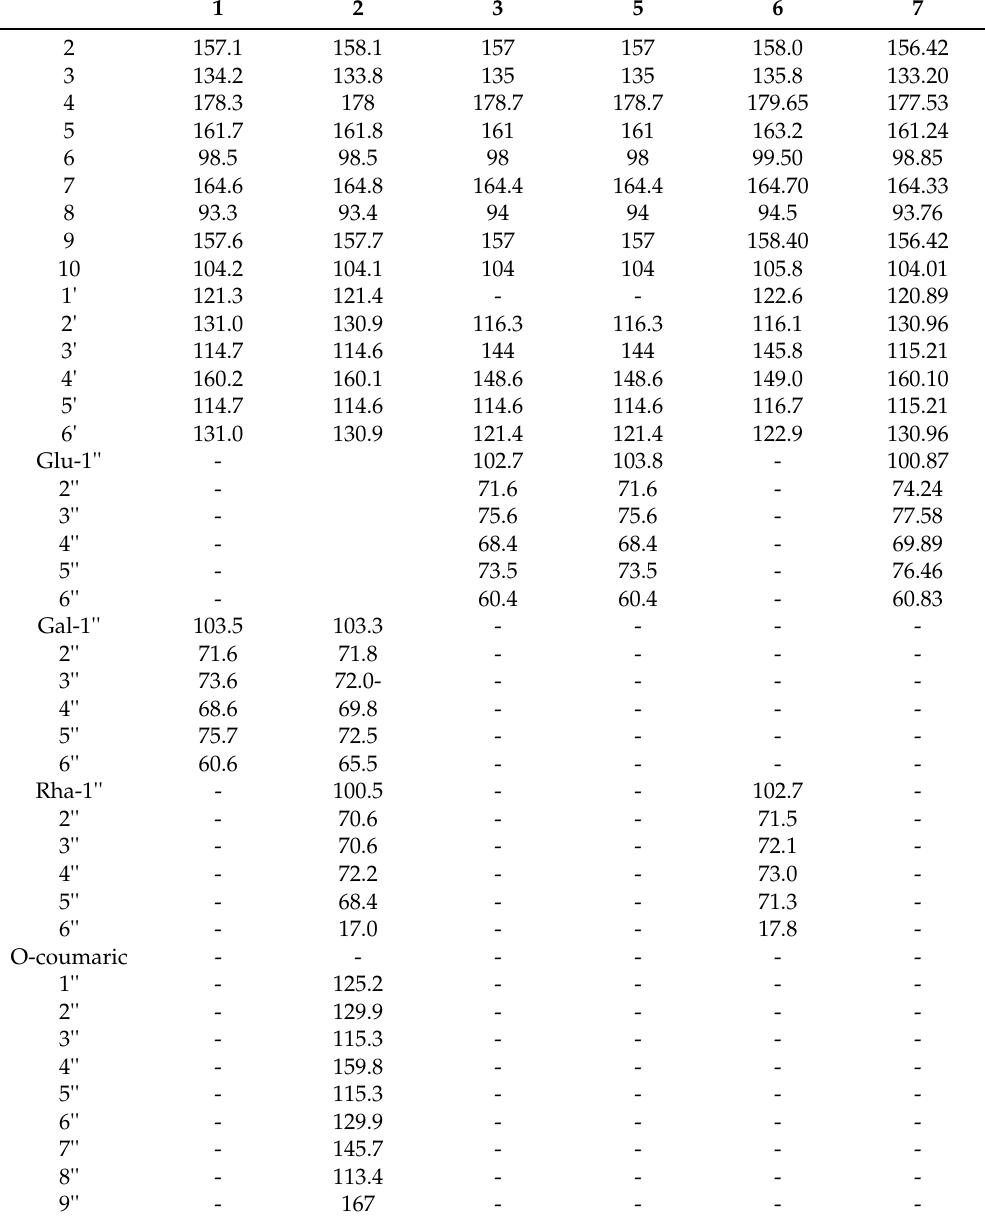
Table 5. 13 C NMR spectral data of isolated compounds ( 1 – 3 , 5 – 7 ) in CD 3 OD ( δ C , ppm, 400